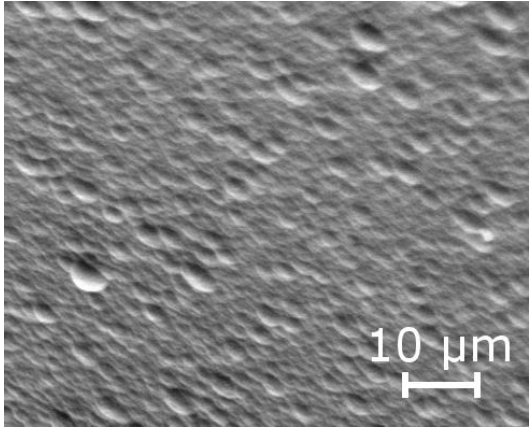
Figure 6. Scanning electron micrograph of a typical poly( N -methylpyrrole) film.